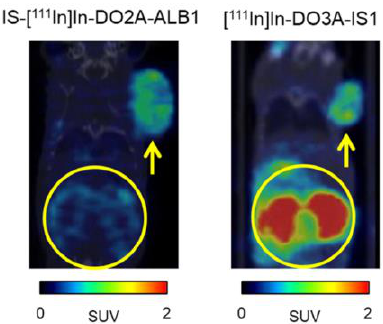
Figure 8. Chemical structures of IS-based CAIX imaging probes.